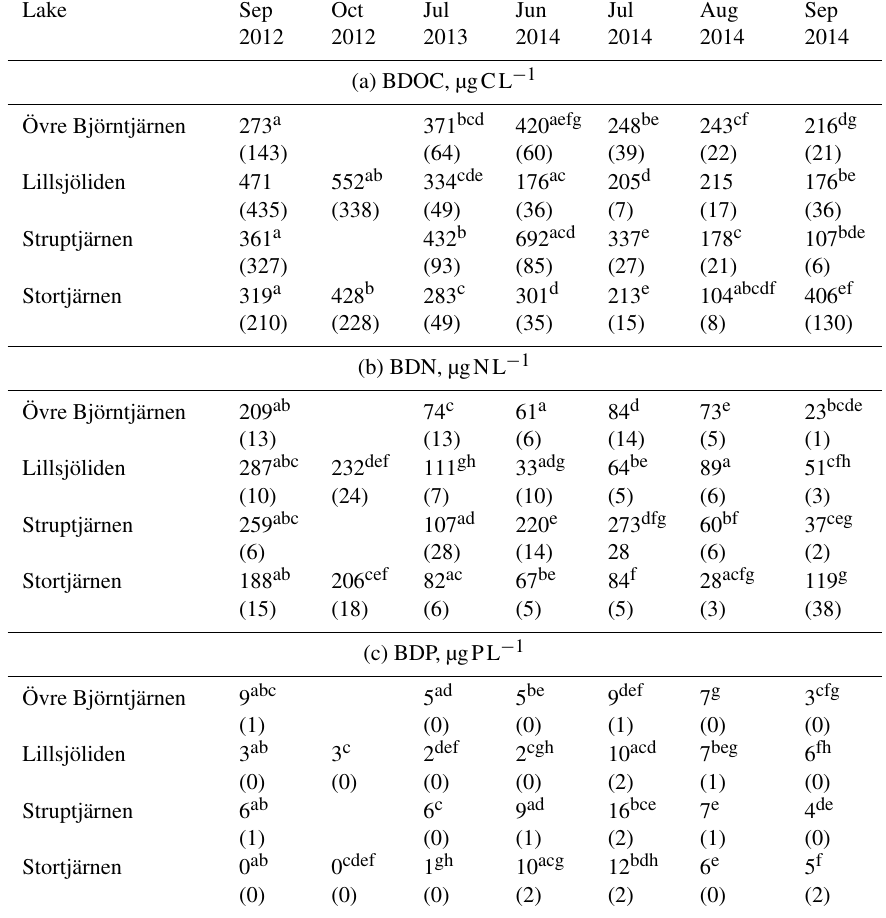
Table 2. (a) Bioavailable dissolved organic carbon, (b) bioavailable total nitrogen, and (c) bioavailable total phosphorus on seven sampling dates (columns). Values show means of five analytical replicates and standard deviations are provided within parentheses. Shared index letters within rows identify dates significantly different from each other ( p <0.05) which were determined by the Kruskal-Wallis h and Dunn’s post-hoc